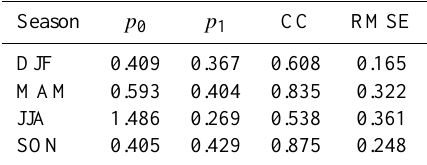
Table 5. Parameters p 0 and p 1 of the linear regression in Eq. (6) be- tween daily ET 0 expressed in mm and computed with the PM and HG formulas for each season (DJF: December, January and Febru- ary; MAM: March, April and May; JJA: June, July and August; SON: September, October and November). The linear correlation coefficient (CC) and the root mean square error (RMSE) are also